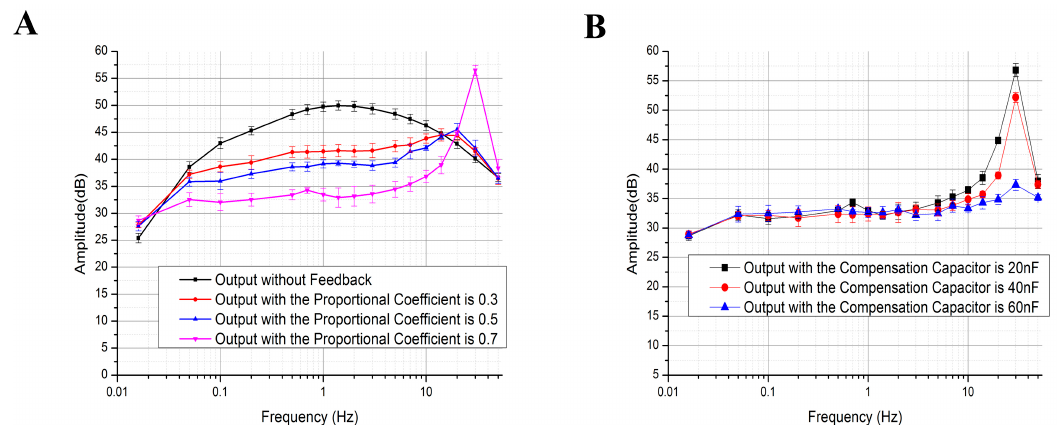
Figure 4. Frequency characterization results of the MEMS electrochemical seismic sensors without feedback, with feedback plus variations in proportional coefficients ( A ) and with feedback plus variations in compensation capacitors ( B ).